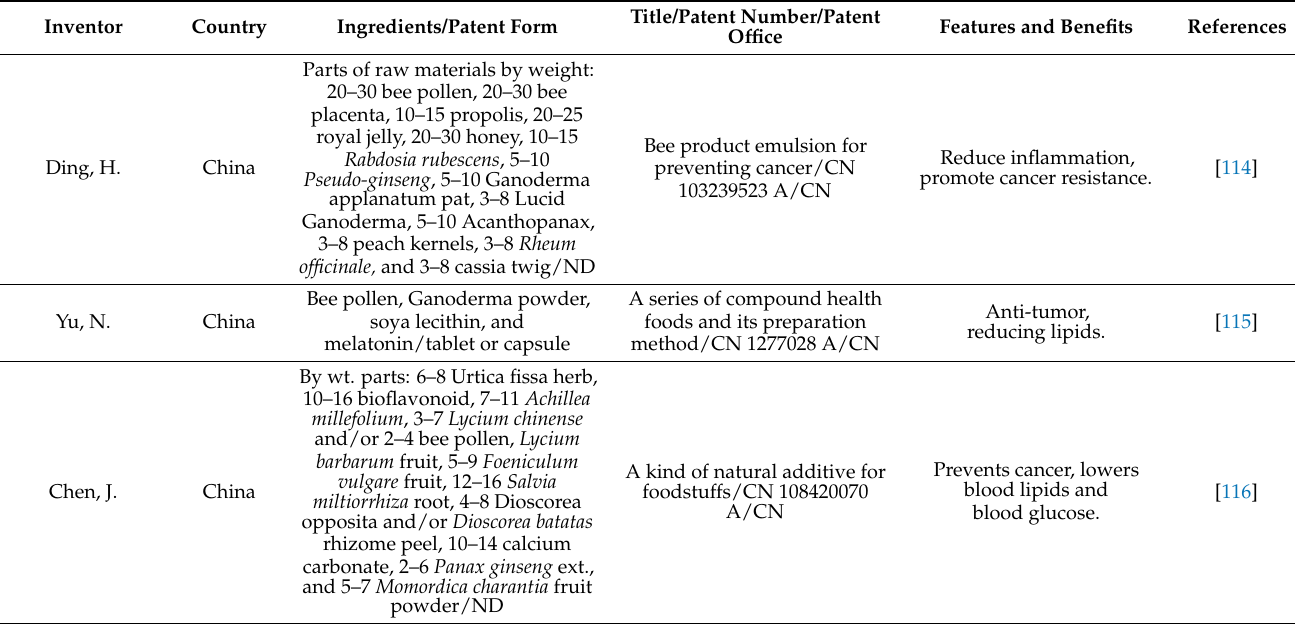
Table 4. Different forms of bee pollen for chronic